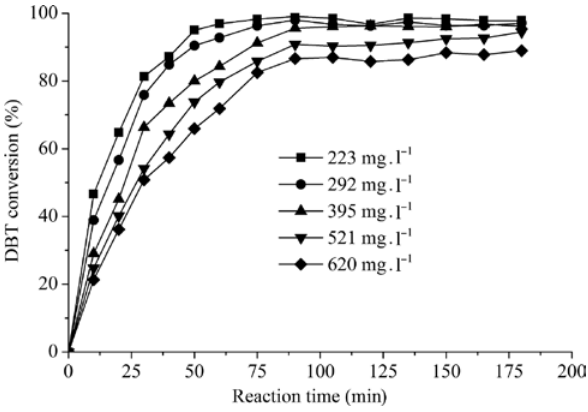
Figure 8: Effect of reaction times in DBT conversion of W/CNT at different initial DBT concentrations.